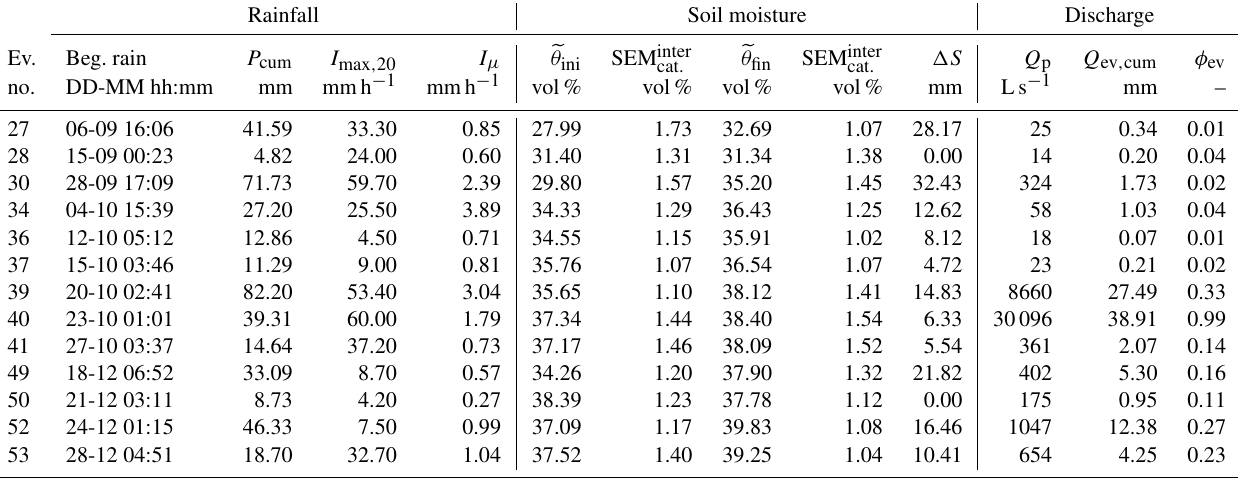
Table 3. Rainfall, soil moisture and discharge characteristics of selected rain events in autumn 2013 in the Gazel catchment: beginning of the rain event, cumulative precipitation ( P cum ), maximum 20min rain intensity ( I max , 20 ), mean intensity ( I µ ), initial soil moisture ( e θ ini ), final soil moisture ( e θ fin ), standard error of the catchment mean (SEM inter cat . ) during initial and final stage, soil storage change at depth 0–50cm ( (cid:49)S ), peak discharge ( Q p ), cumulative total discharge ( Q tot , cum ), cumulative event discharge ( Q ev , cum ) and event-based runoff coefficient calculated with the recursive digital filter method ( φ ev ).